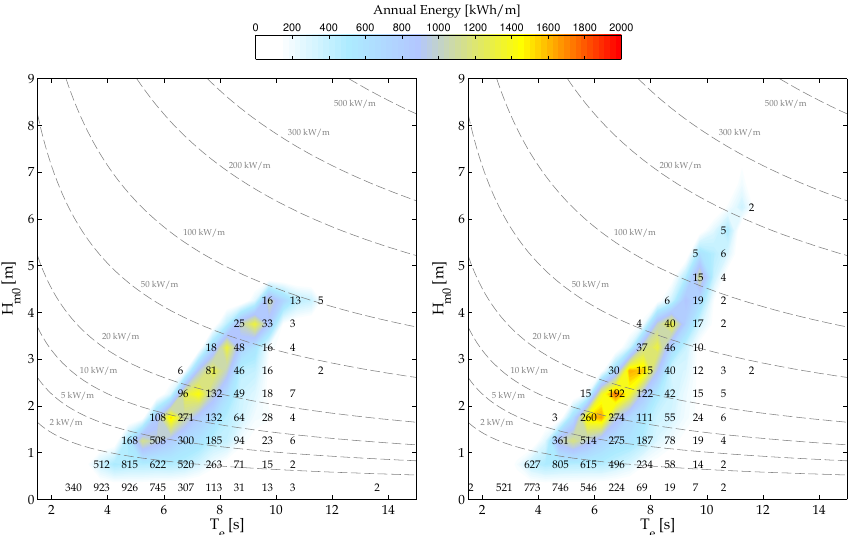
Figure 15. Characterisation of the yearly average wave energy in terms of H m 0 and T e : on the left site HS7 and on the right site HS8. The colour scale represents annual energy per metre of wave front (in MWhm − 1 ). The numbers within the graph indicate the occurrence of sea states (in number of hours per